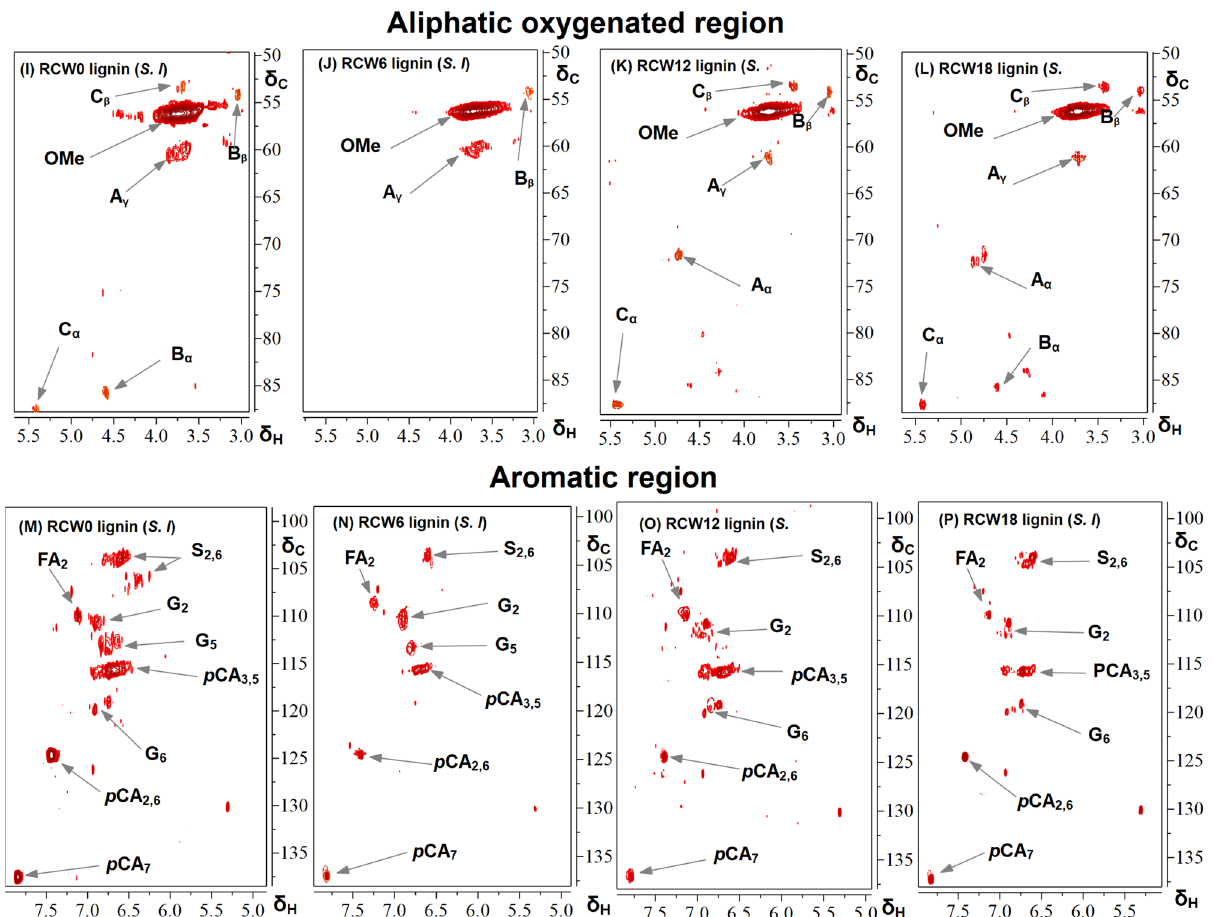
Figure 5. The 2D HSQC NMR spectra of RCW lignins from S. latifolius ( I – P ). ( I – L ) Side chain (δC/ δH 50–90/2.5–5.8) and ( M – P ) aromatic (δC/δH 90–120/5.5–8.0) regions in the 2D HSQC NMR spectra. S. l: Sarcocephalus latifolius , RCW0, RCW6, RCW12 and RCW18: RCW after 0, 6, 12 and 18 months of decomposition in soils, respectively.